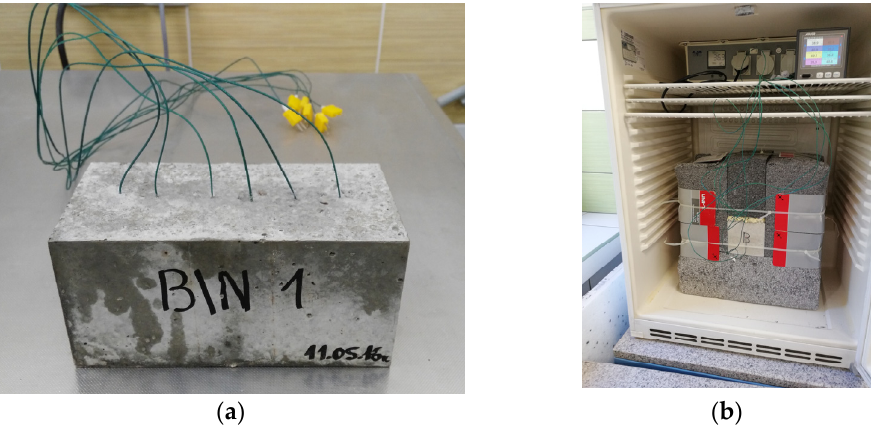
Figure 3. Example specimen ( a ) and the test stand ( b ).